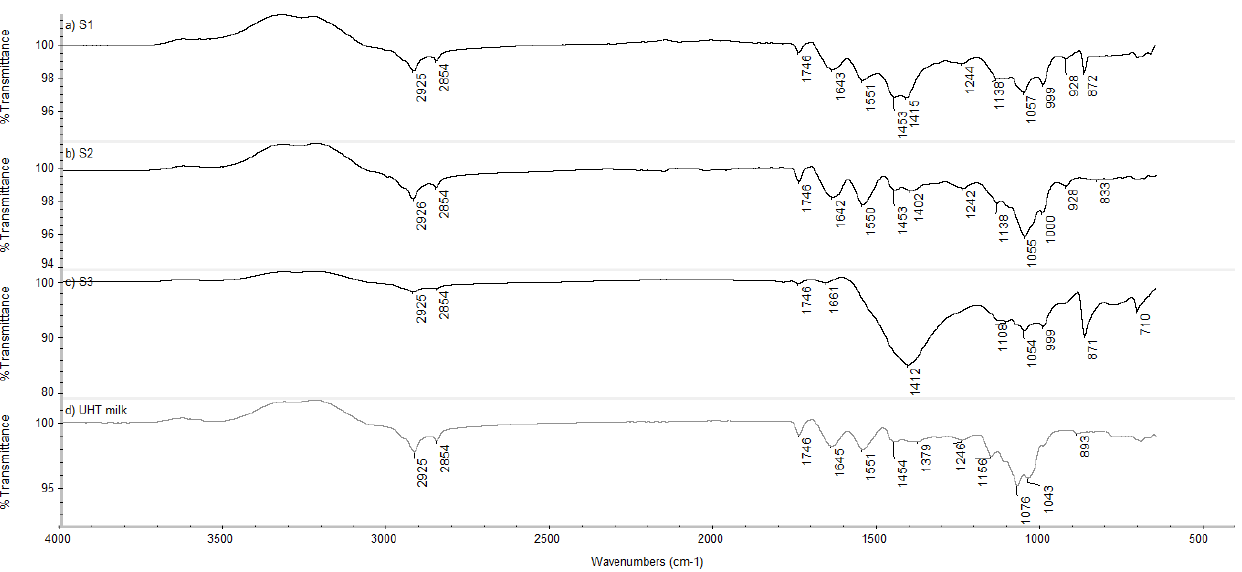
Figure 2. Fourier Transformed Infrared Spectroscopy on Attenuated Total Reflectance (FTIR-ATR) spectra of soy-based beverages ( a ) S1; ( b ) S2; ( c ) S3 and UHT cow milk ( d ) corrected with a background spectrum of